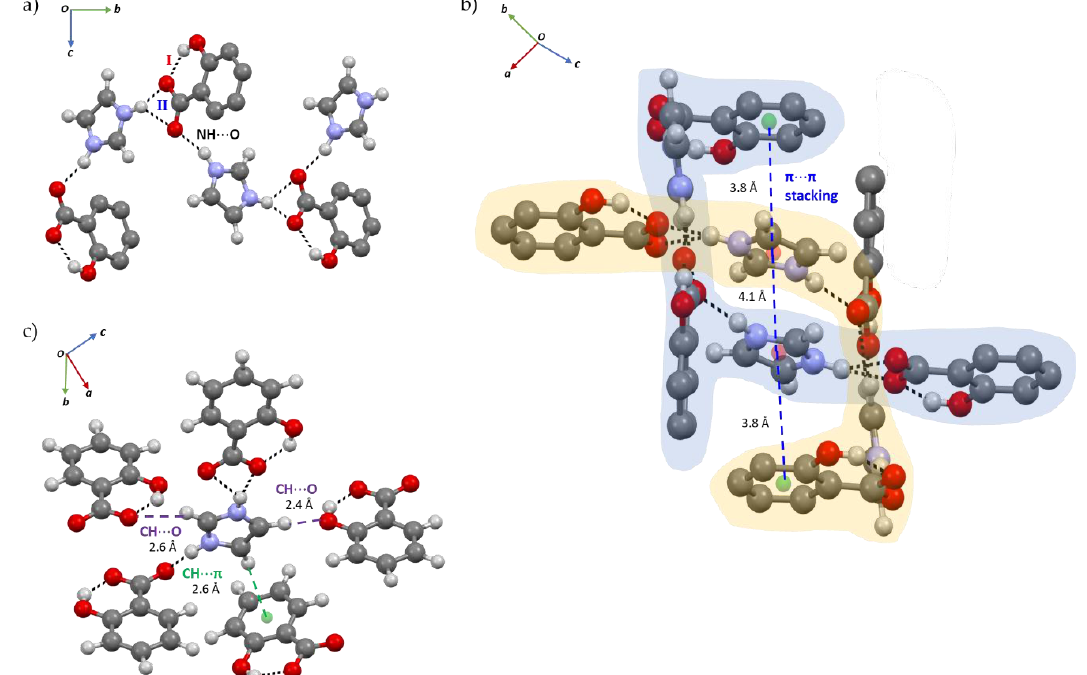
Figure 4. ( a ) Chain of hydrogen bond (HB) interactions between SA and IMI; ( b ) Packing interactions evidencing the channel formed between two crossed-chains and supported by π - π interactions; ( c ) Packing structure evidencing the weak C-H (IMI) ··· π (SA) and C-H (IMI) ··· O (SA) HB interactions. SA aliphatic hydrogen atoms were omitted for